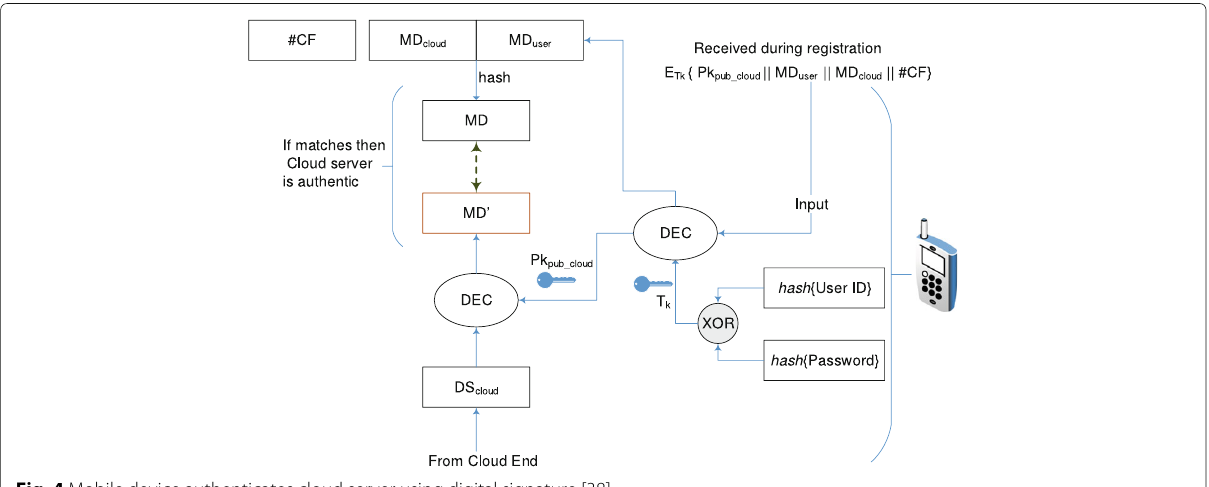
Fig. 4 Mobile device authenticates cloud server using digital signature